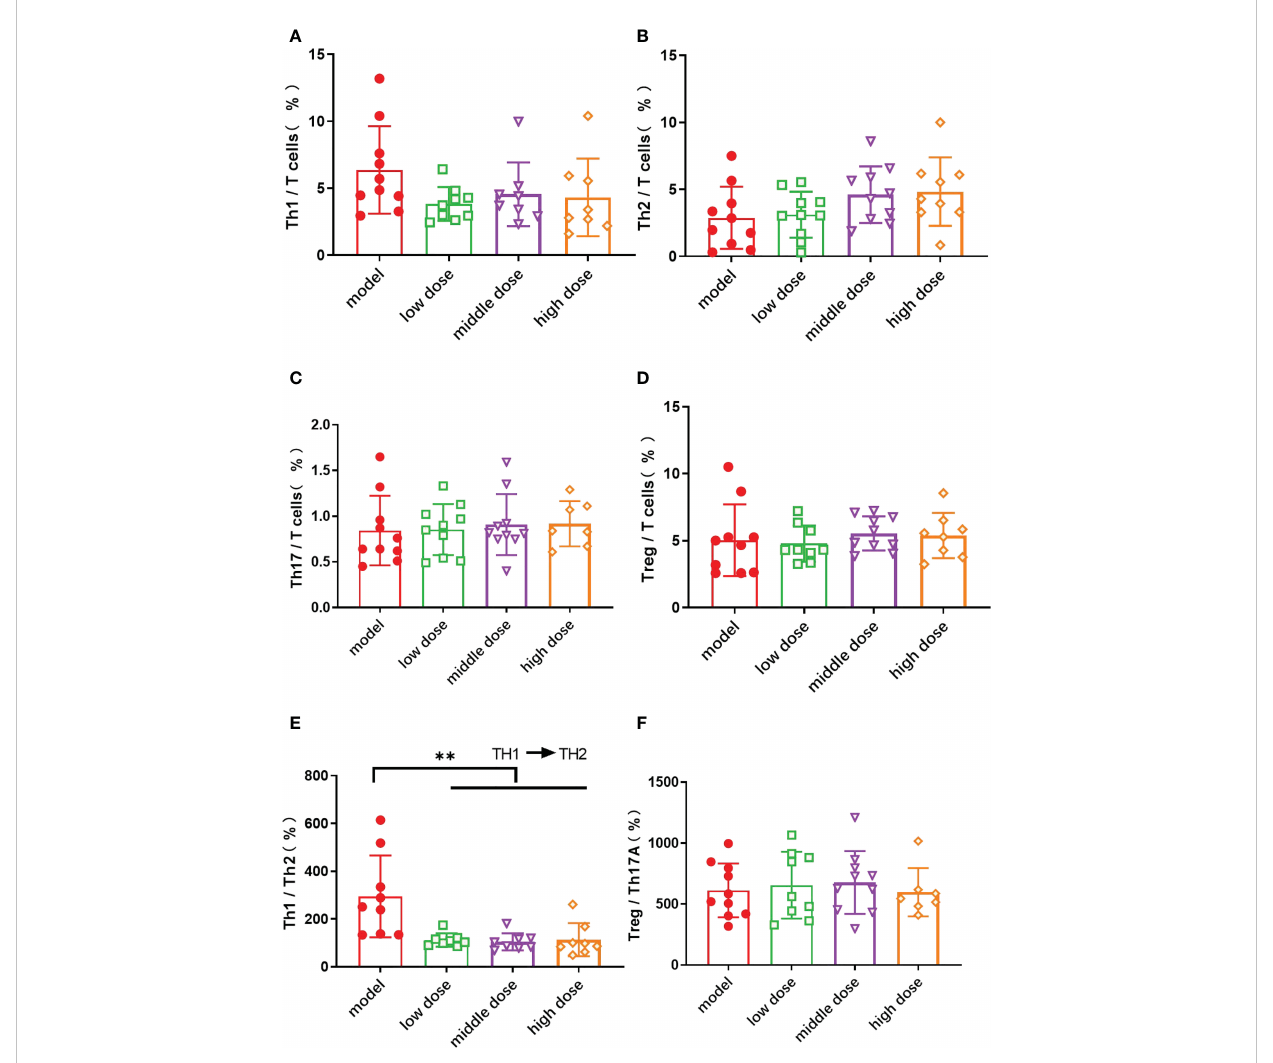
FIGURE 5 The proportion of Th cell subsets in CD3+ T cells in the spleen of mice in each group at the 20th week. (A) : the proportion of Th 1 cells in CD3+ T cells; (B) : the proportion of Th 2 cells in CD3+ T cells; (C) : the proportion of Th 17 cells in CD3+ T cells; (D) : the proportion of Treg cells in CD3+ T cells; Data are presented as mean ± SD. **p ≤ 0.01 vs. Model; (E) : the ratio of Th1 cells to Th2 cells; (F) : the ratio of Treg cells to Th17 cells. In model group, low dose group, middle dose group, n=10; in high dose group, n=9. Outliers were removed using the ROUT (Q = 1%) method, Th1: low dose (10.4), middle dose (17.7, 19.4), high dose (20); Th17: high dose (10, 2.78); Treg: low dose (17.8) 、 high dose (20);Th1/Th2%: model (1054.8) 、 low dose (981.1,816.7) 、 middle dose